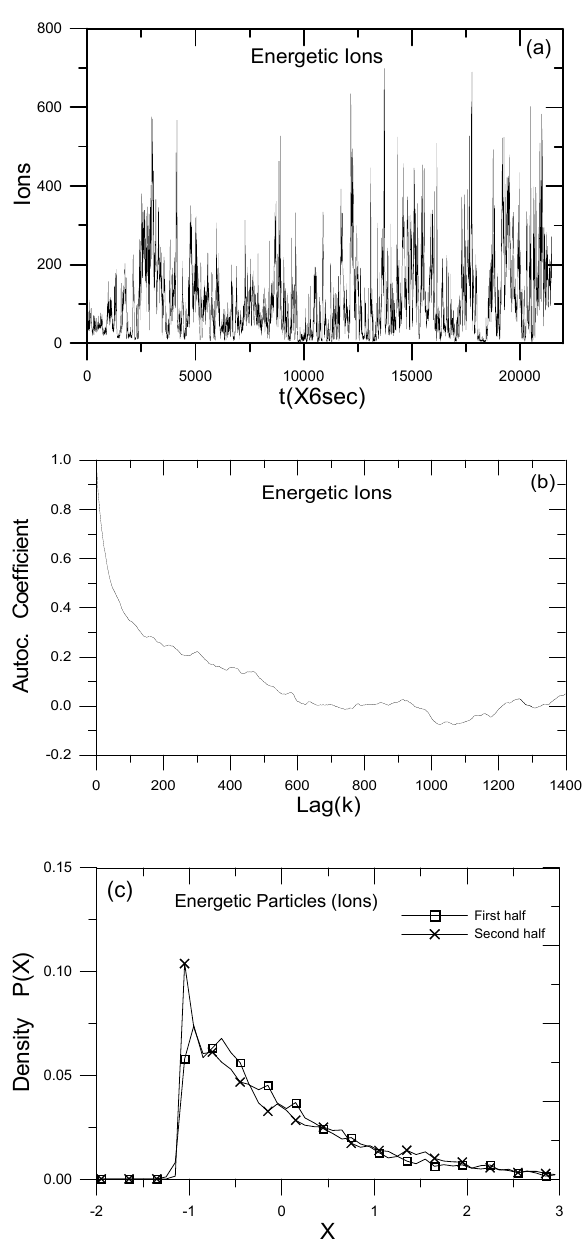
Figure 7 Fig. 7. (a) Measurements of the magnetospheric energetic ions with six seconds time resolution during the days 7–8 December (day 341, 00:00 UT to day 342, 12:00 UT), 1994. The bursting character of the energetic ions is obvious and indicates the strong coupling of the magnetosphere with the solar wind. (b) The autocorrelation co- efficient for the first 1400 units of the lag indicates two different processes. The first corresponds to an abrupt decay of autocorre- lation coefficient and the second to a slow decay. (c) Amplitude distribution for the first and second half of the magnetospheric en- ergetic ions time series. It is apparent the stationarity of the time